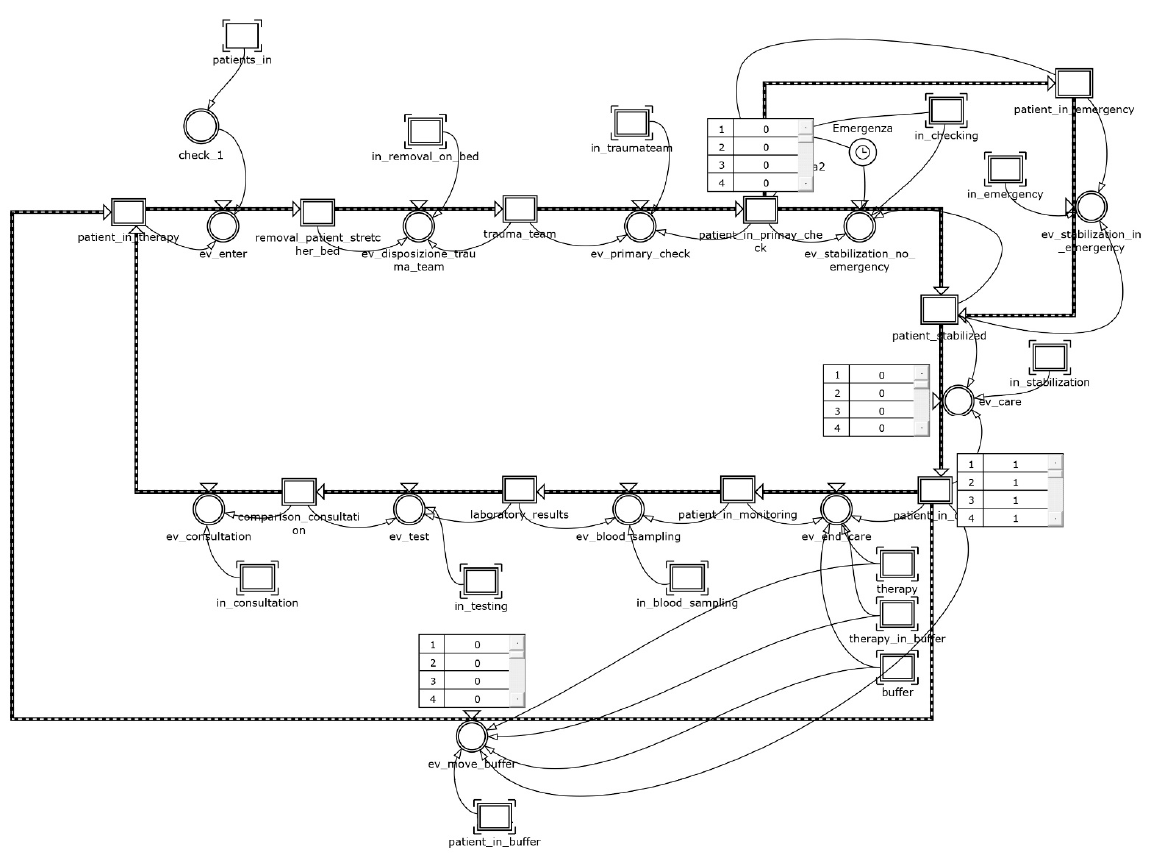
Figure 9. The chain of events module for the cell design scenario.